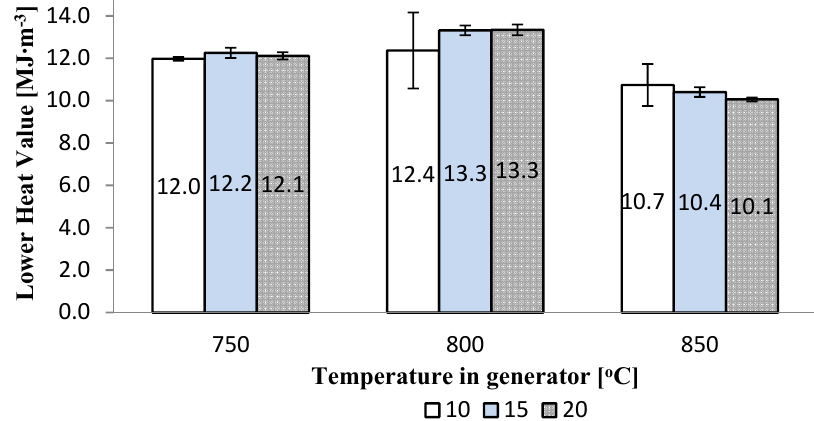
Figure 6. Impact of temperature in the generator and the steam outflow rate (10; 15; 20 kg · h − 1 ) on the syngas lower heat value.